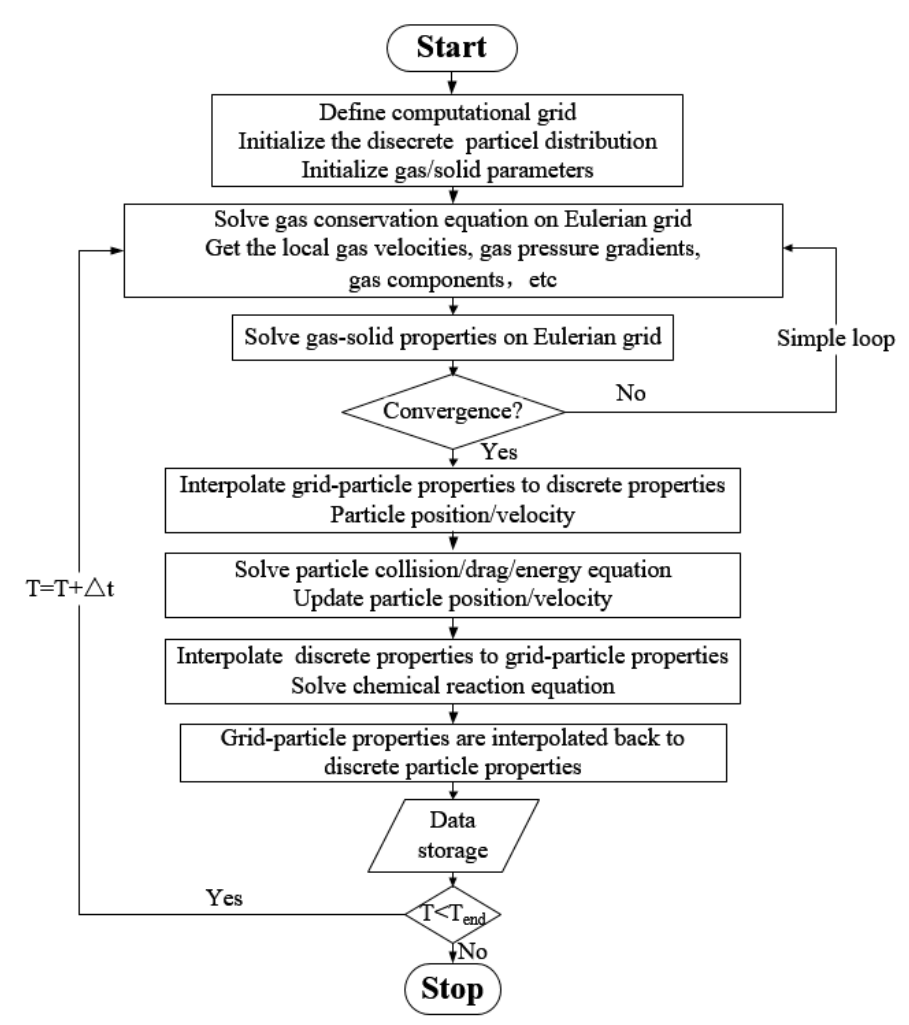
Figure 2. Calculation flow chart.